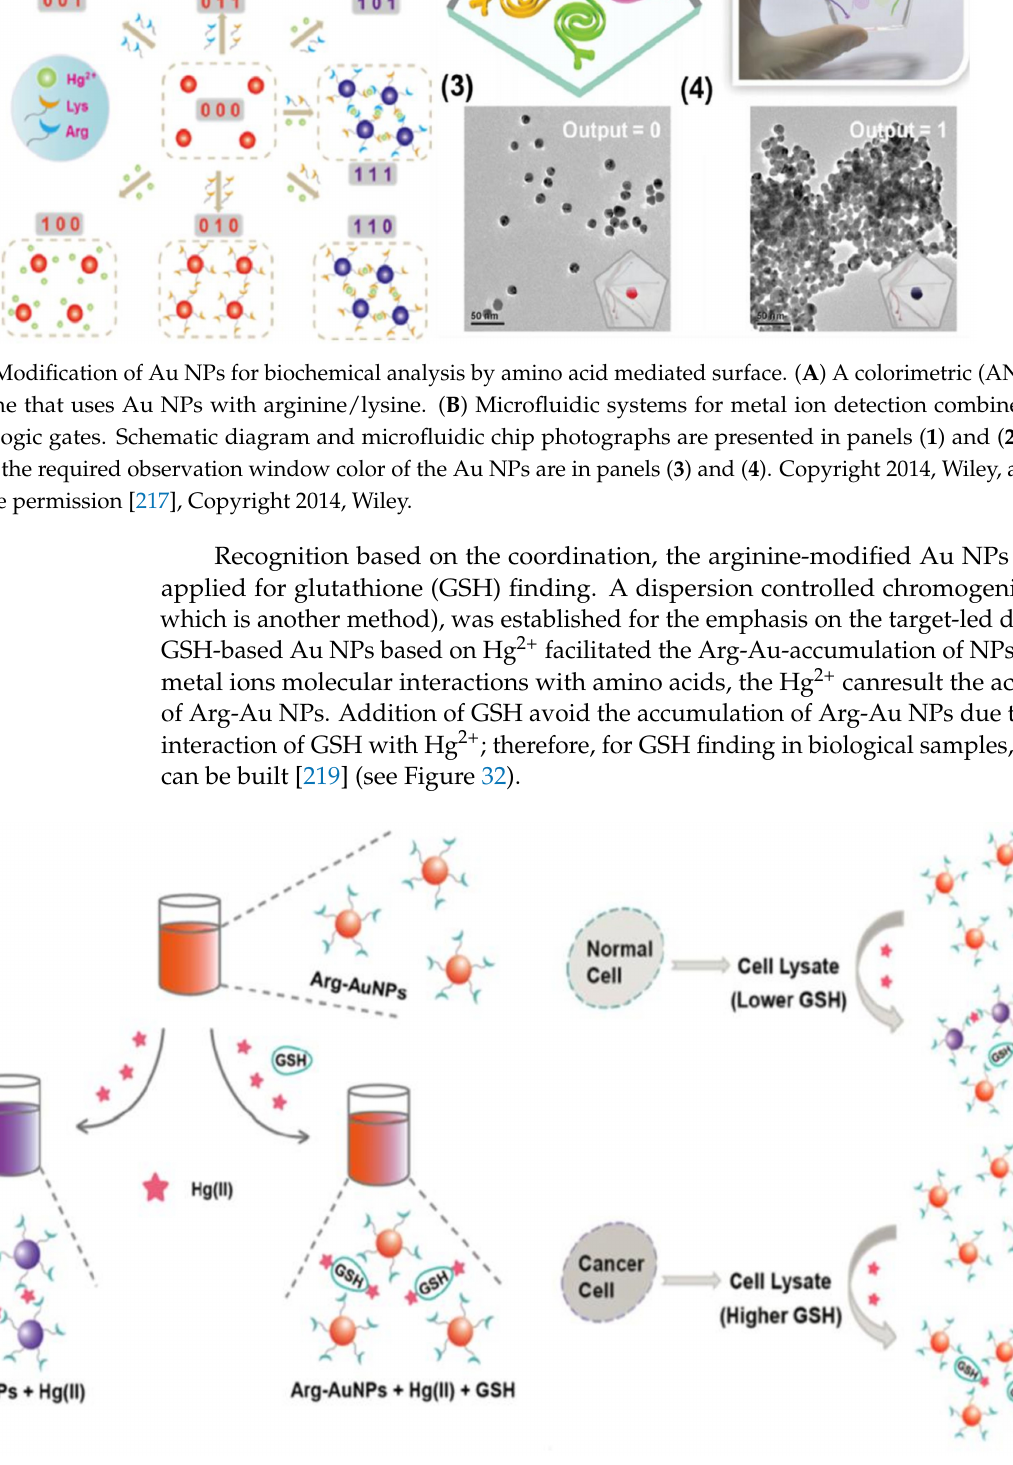
Figure 32. Arginine-modified Au NPs for GSH sensing in cell cancer are distributed regulated by chromogenic approach. Adapted by reference permission [219], Copyright 2015,